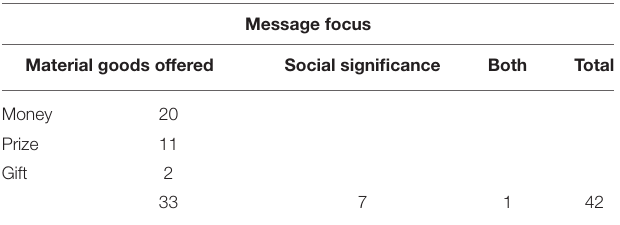
TABLE 1 | The number of messages appeared in advertisements of plasma donation companies in the country being studied. Message